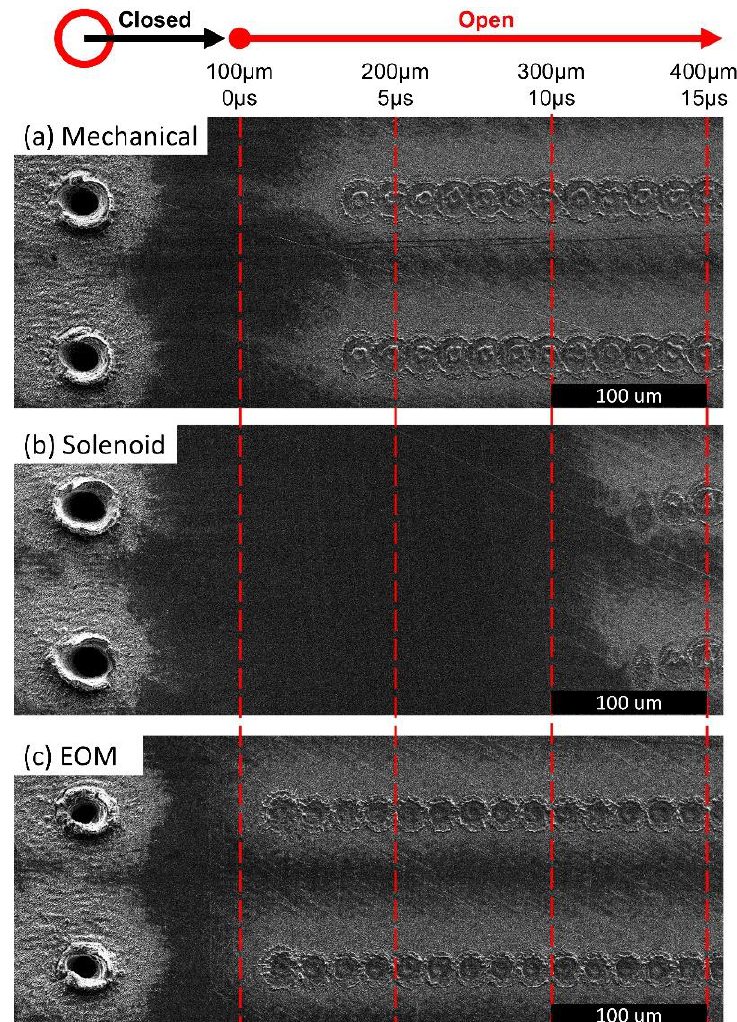
Figure 5. SEM micrographs demonstrating how the opening time of each shutter was measured. The opening time can be discerned based on the distance of the first ablating pulse from the deep hole on the left. ( a ) Mechanical shutter. ( b ) Solenoid Shutter. ( c ) EOM shutter. Next, we consider the performance of each shutter while responding to a long sequence of open/close commands. Figure 6a graphs the measured position of each shutter for a period of T = 200 ms (i.e., 100 ms open, 100 ms closed, repeating). In this figure, the grey shaded blocks represent times where the shutter is commanded to be closed, and the white shaded blocks represent open segments. Meanwhile, the actual shutter position is represented by a number ranging from zero (completely closed) to one (completely